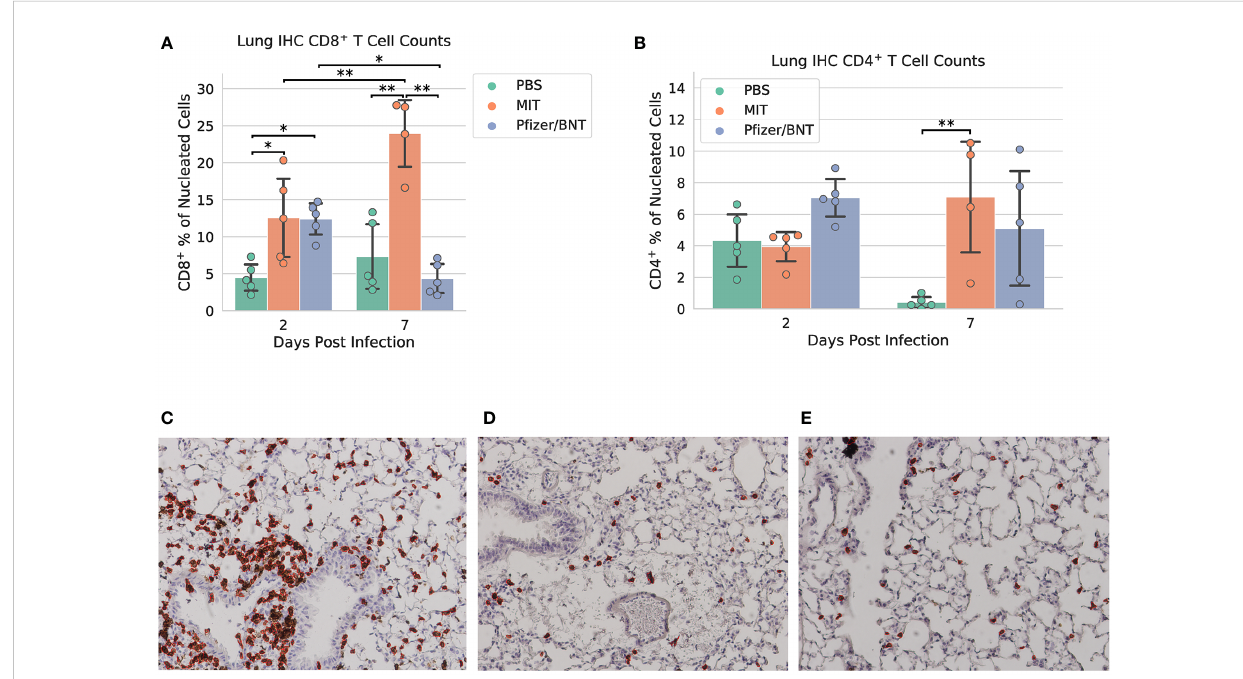
FIGURE 4 Lung immunohistochemistry for CD8 + and CD4 + cells. Counts of (A) CD8 + and (B) CD4 + T cells expressed as a percentage of all nucleated cells visible in each fi eld from lung tissue. Example CD8 + stain images at 7 dpi for (C) MIT-T-COVID, (D) P fi zer/BNT, and (E) PBS-immunized animals. Lung samples were subjected to IHC staining for CD8 (brown) with hematoxylin counterstain (blue). Images were taken at 10x magni fi cation. Red outlines in (C-E) indicate CD8 + cells identi fi ed and counted by CellPro fi ler software (Supplementary Methods). Error bars indicate the standard deviation around each mean. P values were computed by two-way ANOVA with Tukey ’ s test. * P < 0.05 and ** P < 0.01. See also Supplementary Figures 5 –